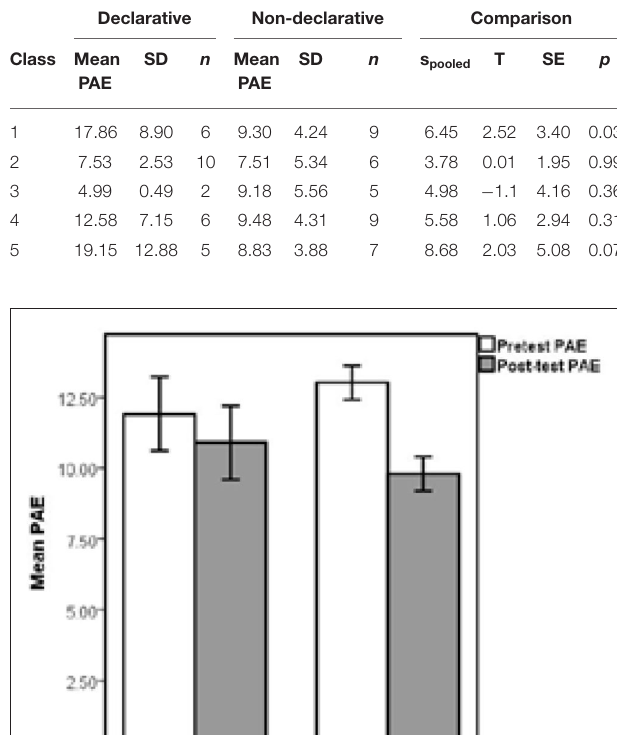
TABLE 2 | Effect size estimates for CCMA.